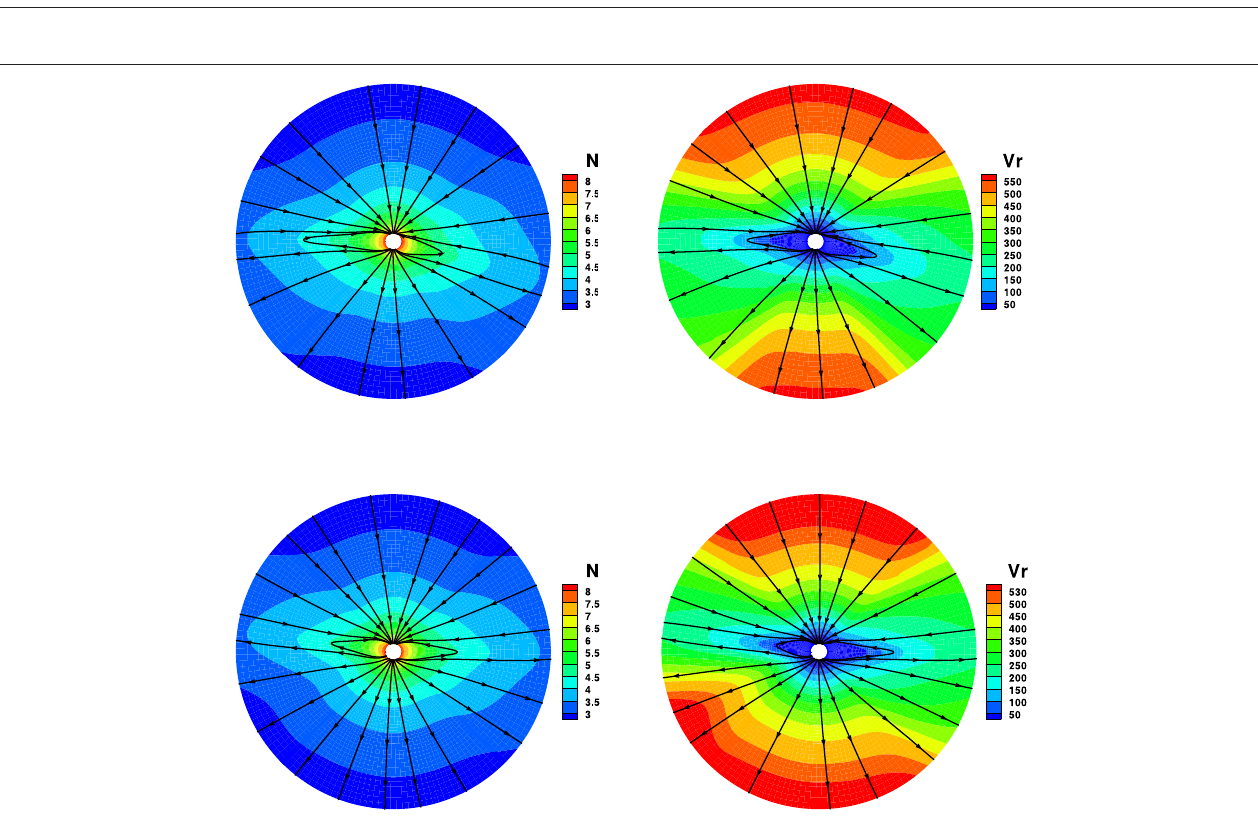
FIGURE 1 | Partition of a sphere into six identical components with partial overlap (left) and one-component mesh stacked in the r direction (right).